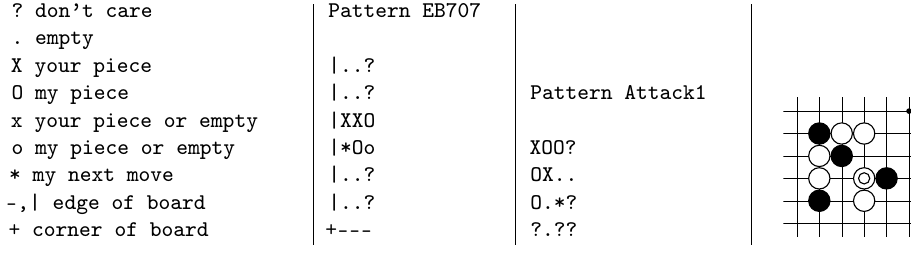
Figure 1. Patterns in GnuGo are stored in text files. These are two examples with explanation on the left. The first example is about blocking a possible incursion. The second is a standard tactical move, a net. The configuration on the right is a possible match for the second pattern.